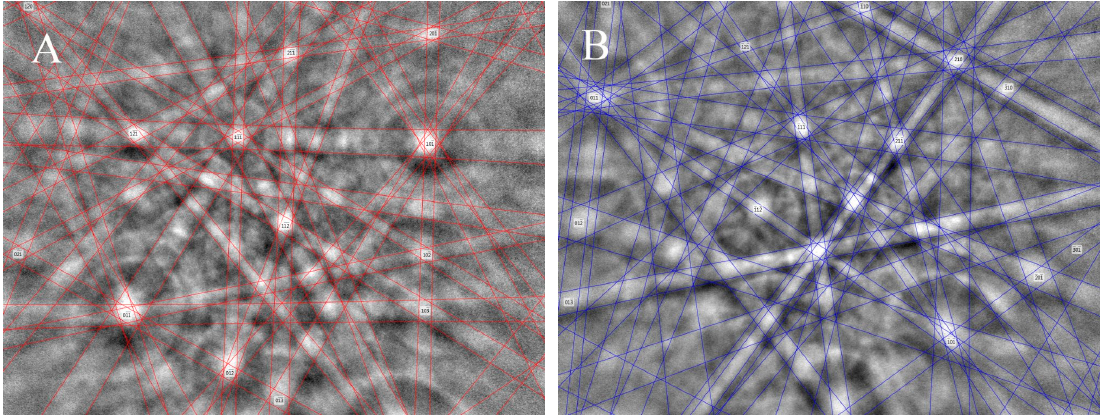
Figure 29. Electron backscatter diffraction (EBSD) images of ( A ) dzharkenite and ( B ) ferroselite (right) from P ř íbram, with indexed Kukuchi bands. Photo by M. Racek.